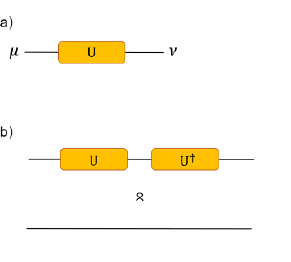
Figure 37 . (a) Tensor R . (b) Tensor R is proportional to isometries along two